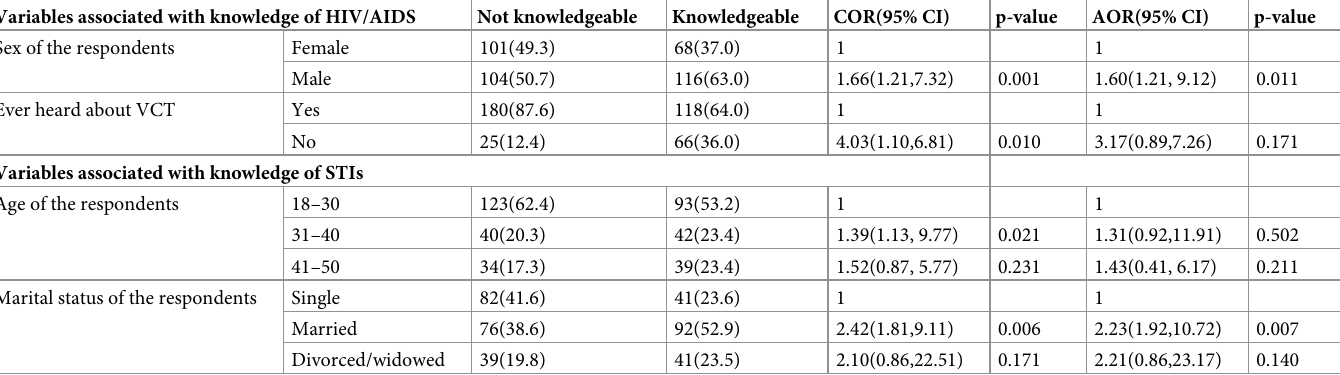
Table 7. Determinants of knowledge about HIV/AIDS and other STIs among respondents in North-shewa zone, Ethiopia, 2019. Variables associated with knowledge of